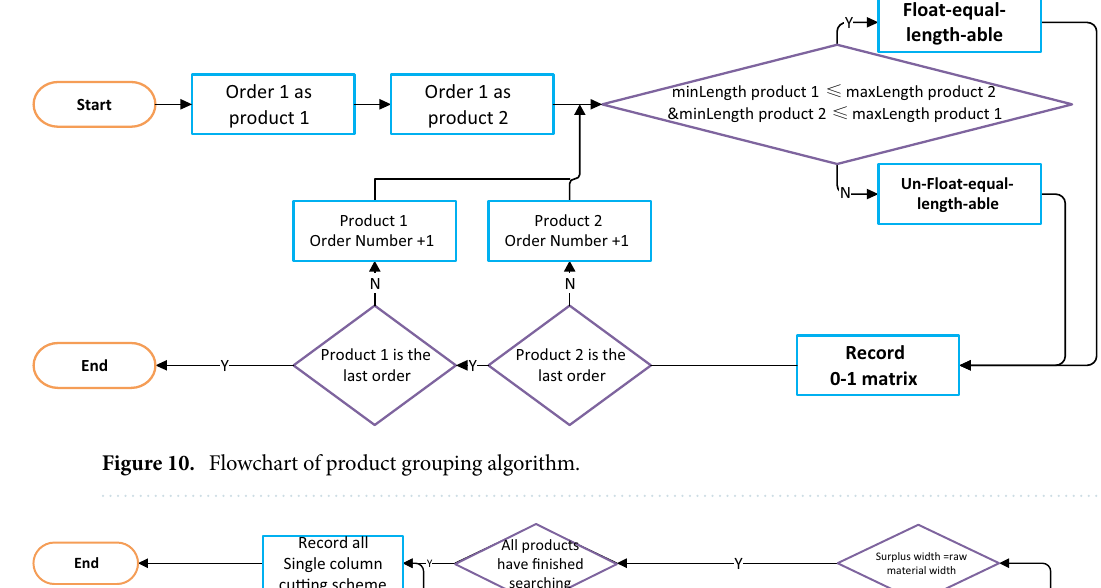
Figure 10. Flowchart of product grouping algorithm.